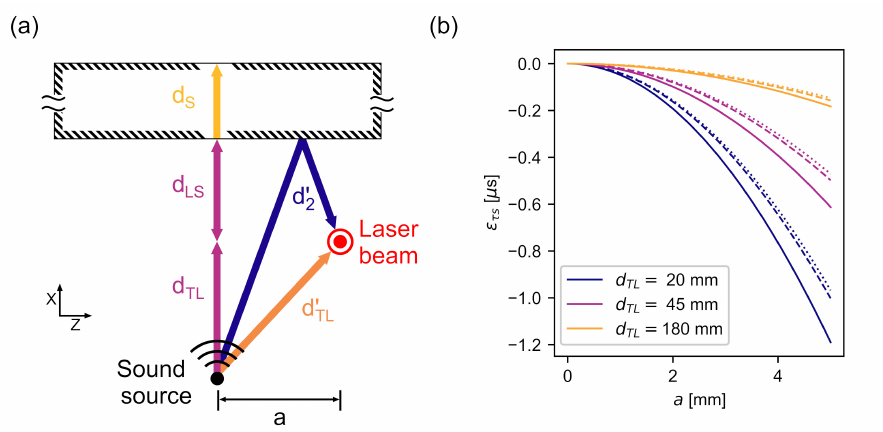
Figure 4. ( a ) Sketch of an erroneous laser positioning. The arrows indicate the sound paths. The co- ordinate system is rotated about the x-axis compared to Figure 3a. ( b ) Calculated ToF due to laser positioning errors for distances that are used in experimental verification. Solid lines: d LS = 20 mm, dashed lines: d LS = 70 mm, dotted lines: d LS = 110